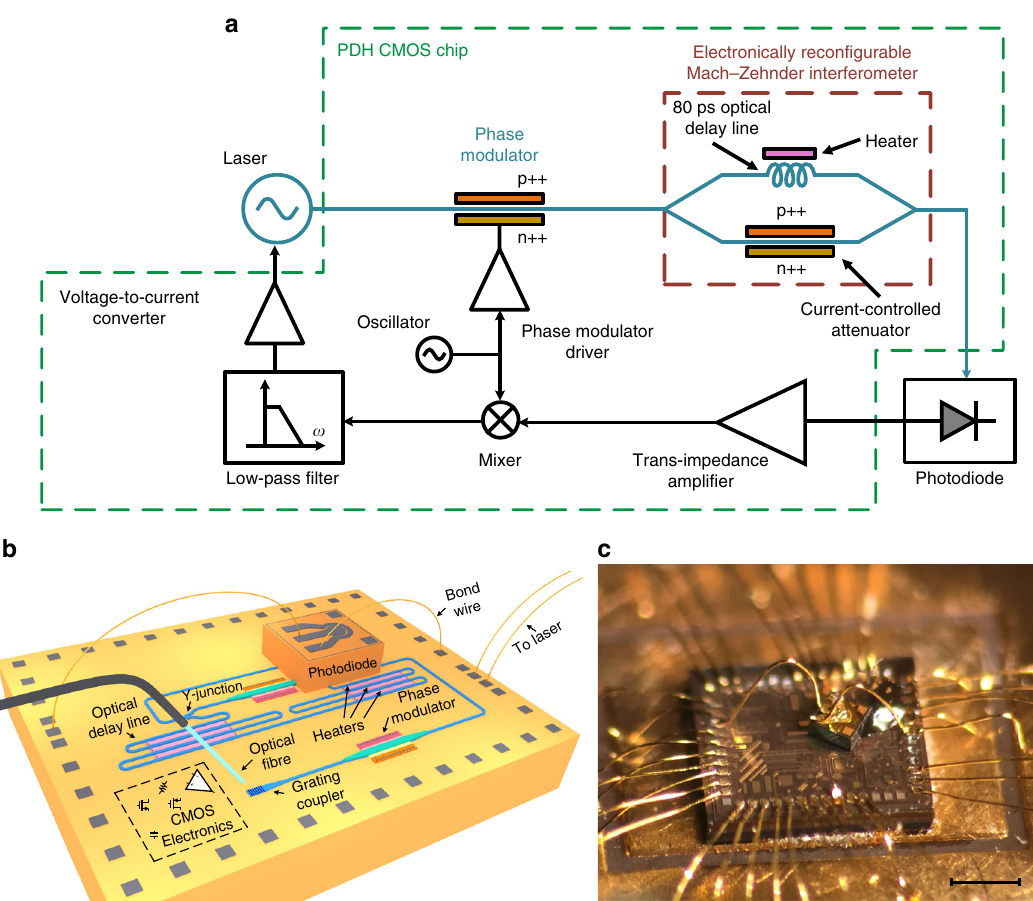
Fig. 1 The integrated Pound − Drever − Hall laser frequency stabilization system. a The block diagram of the reported Pound − Drever − Hall (PDH) chip implemented in 180 nm GF7RFSOI CMOS silicon-on-insulator process. The laser output is phase modulated using a p-doped-intrinsic-n-doped (PIN) phase modulator, passed through the electronically recon fi gurable Mach − Zehnder interferometer (MZI) with 80 ps delay imbalance, and photo-detected. The photo-current is ampli fi ed and converted to a voltage using a trans-impedance ampli fi er (TIA) and mixed with the same electrical signal used to phase modulate the laser. The mixer output is fi ltered, ampli fi ed, converted to a current and injected to the laser gain section to lock the laser to the notch in the MZI frequency response. The output of the voltage-to-current converter, the read-out signal, is asymmetric with respect to the frequency of the notch in the MZI frequency response, f notch . Therefore, the read-out signal indicates both the difference between the laser frequency and f notch and whether the laser frequency is greater or less than f notch (Supplementary Note 1). Note that the modulation sidebands are essential to detect the sign of the read-out (error) signal required to tune the laser toward f notch . b The structure of the reported PDH system. c Micro-photograph of the CMOS chip with a photodiode mounted on top. The details of the integrated CMOS chip are included in Supplementary Note 5 and Supplementary Fig. 6. The hybrid integration of the photodiode chip with the CMOS chip is discussed in Supplementary Note 8. Scale bar,